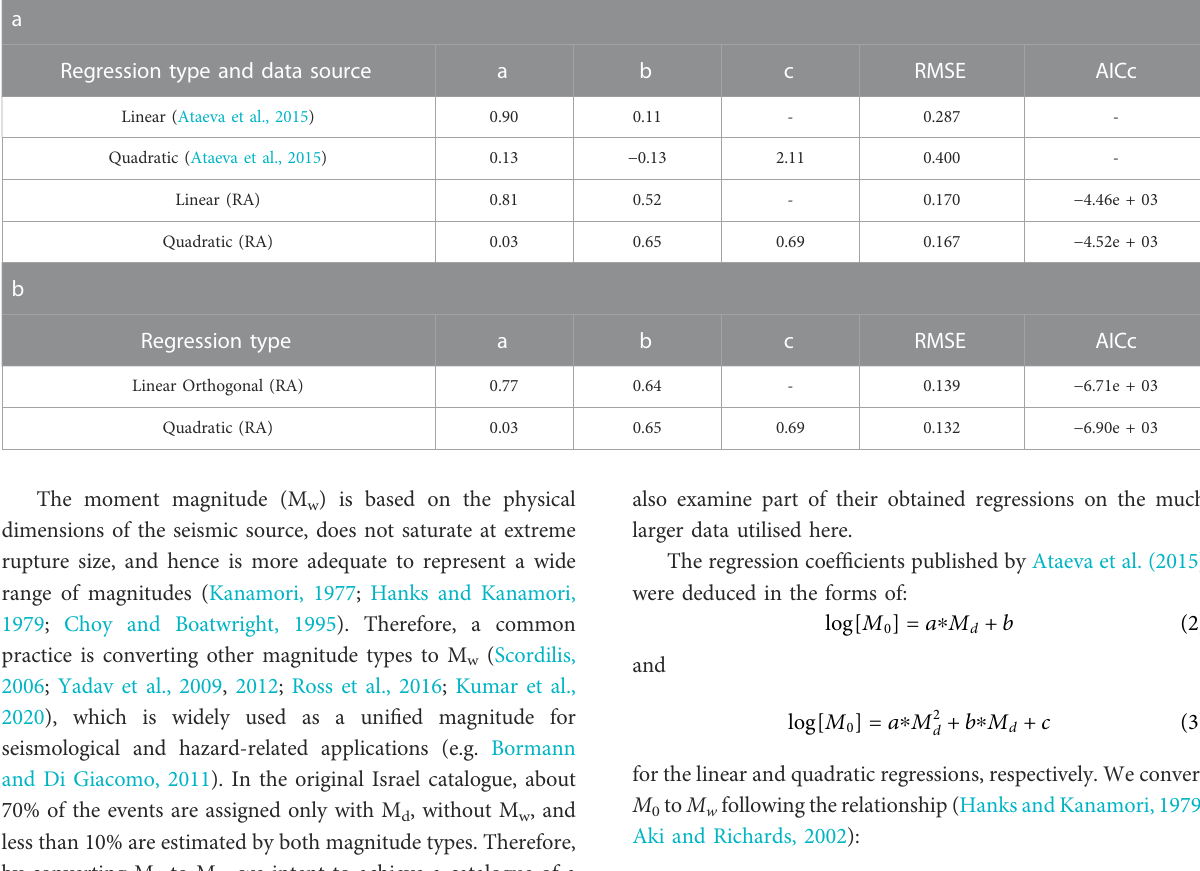
TABLE 2Coef fi cientcorrelationparameters (a, b,c)that correspond tolinear andquadratic regressions ofthe forms M w (cid:2) a*M d + b and M w (cid:2) a*M 2 d + b*M d + c , respectively;RMSEandAICcoftheseregressionsareinrespecttoearthquakeslocatedwithinRA;a)Theregressioncoef fi cientsofAtaevaetal.(2015)arefrom S-wave analysis and the magnitude range of 2 . 7 ≤ M d ≤ 5 . 6 , and were achieved through Eqs 1 – 3 (see Methods section); b) Comparison between orthogonal regression and quadratic OLS regresion.